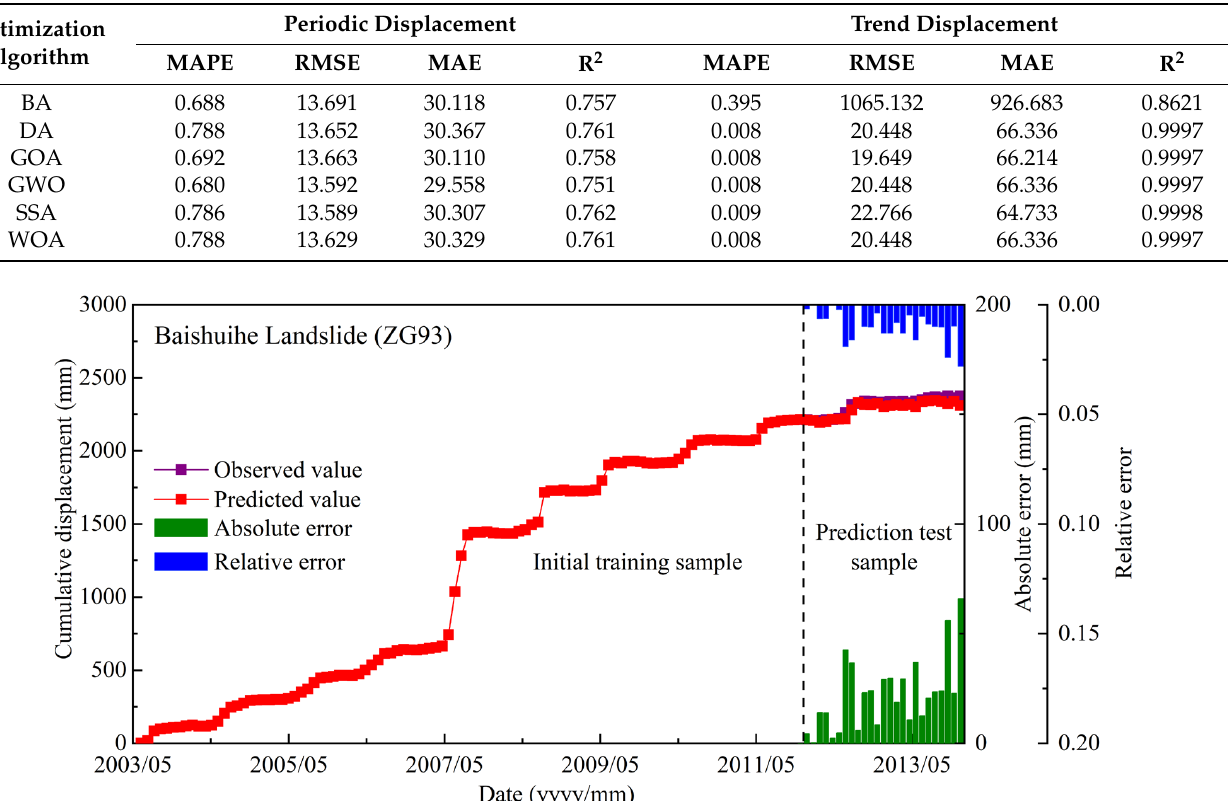
Figure 18. Comparison of predicted displacement and measured displacement.